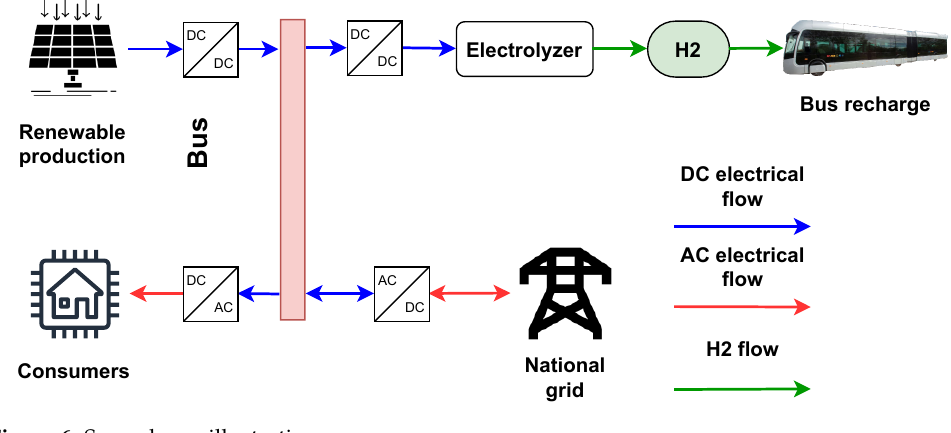
Figure 6. Second case